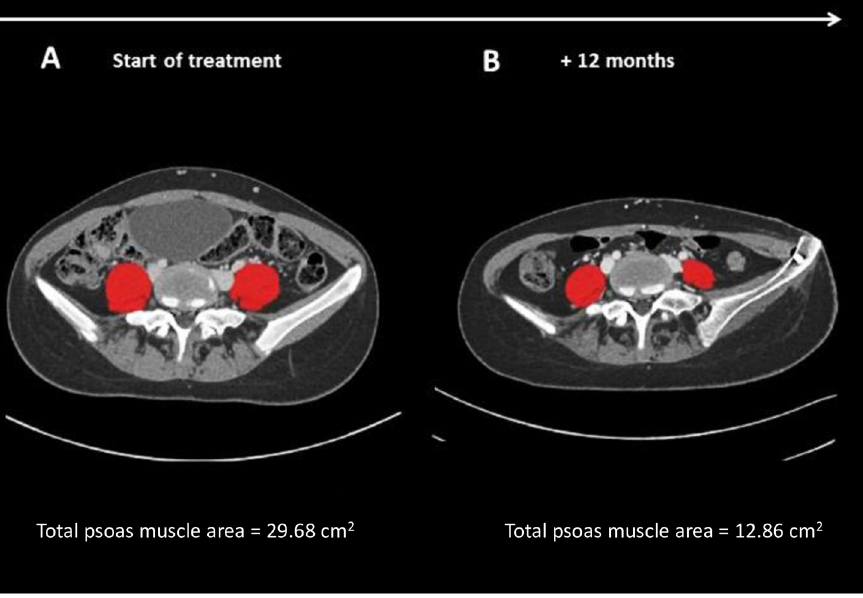
Figure 1. tPMA (in red color) measured from single cross-sectional abdominal CT images at the level of L4–L5 in the same patient, at diagnosis, and after 12 months of treatment.